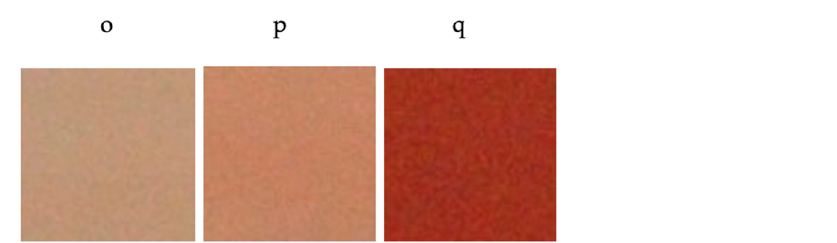
Figure 12. UV-Vis spectrophotometry of pigment Y 0.98 Al 0.98 Cr 0.04 O 3 fired at different temperatures.